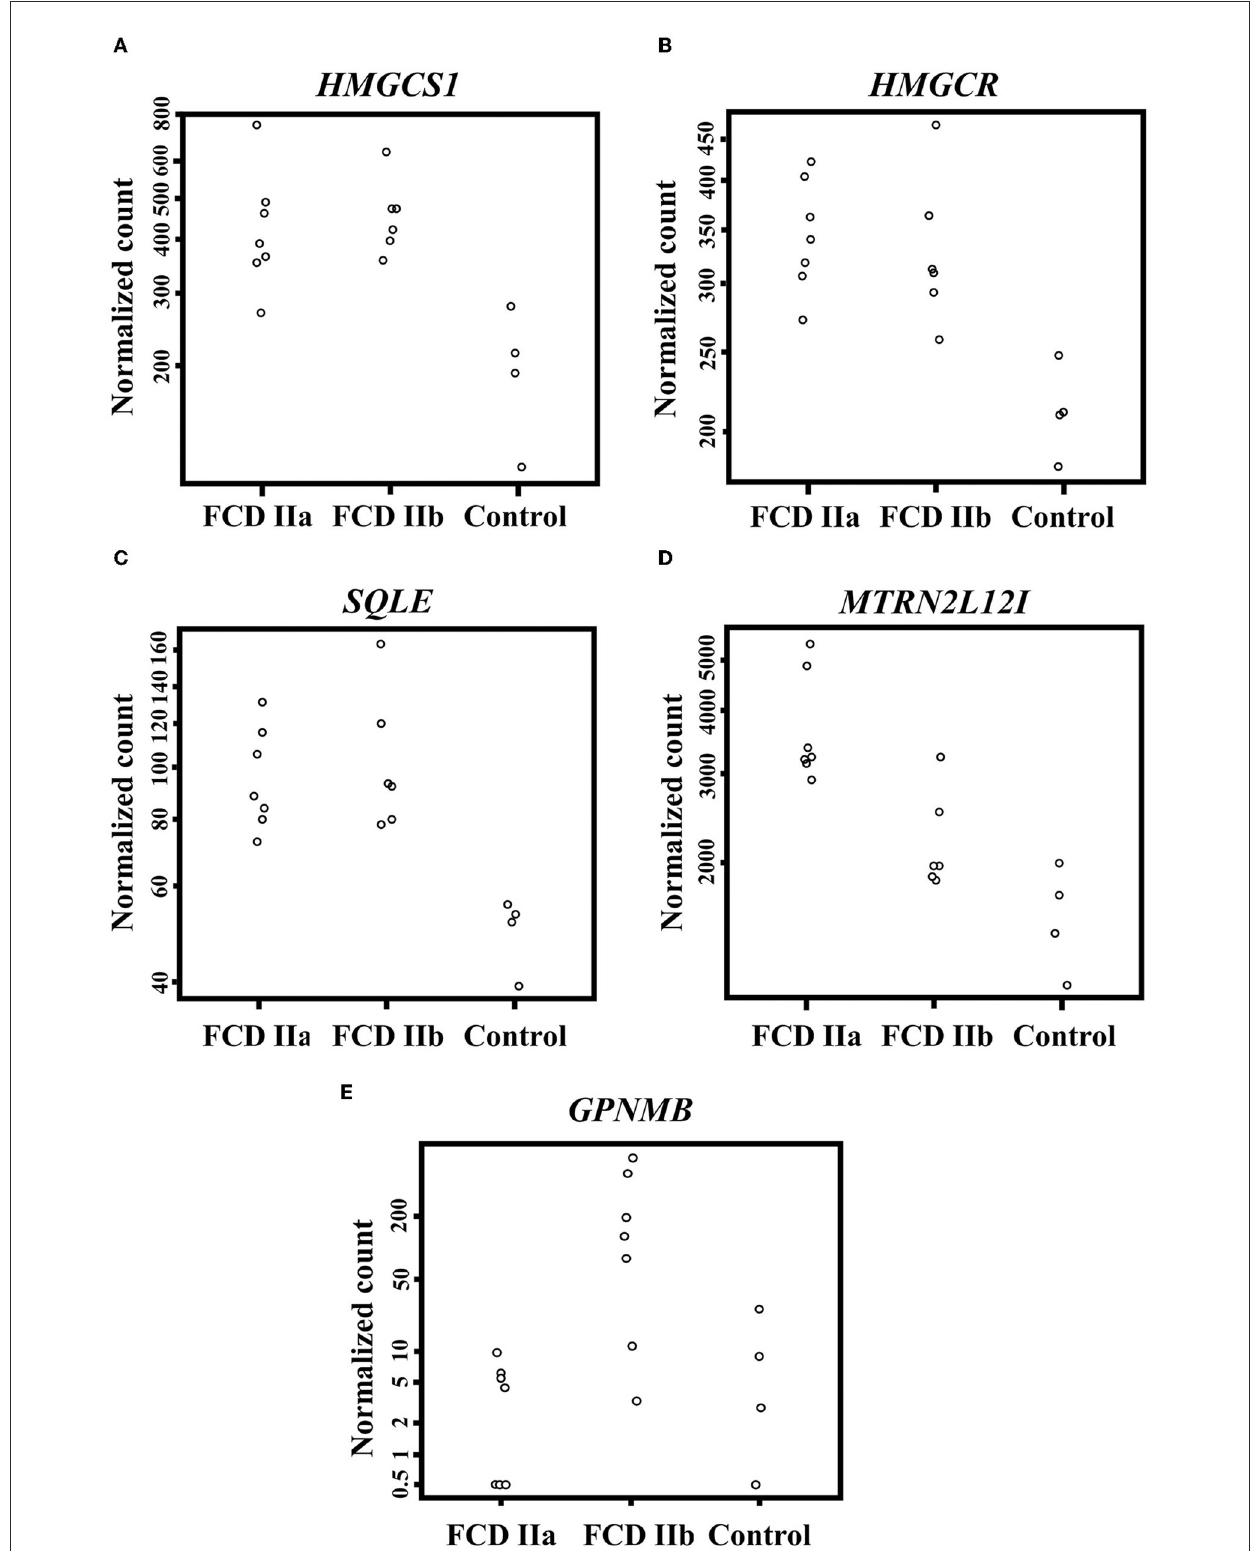
FIGURE4 Differentially expressed genes when comparing the autopsy (control), focal cortical dysplasia (FCD) ILAE type IIa (FCD IIa) and FCD ILAE type IIb (FCD IIb) groups. (A–D) Expression of HMGCS1 , HMGCR , SQLE, and MTRNR2L12 , respectively, in the gray matter. (E) Expression of GPNMB in the white matter. Please refer to the text for details on fold change for each gene and the corresponding statistical significance (adjusted p